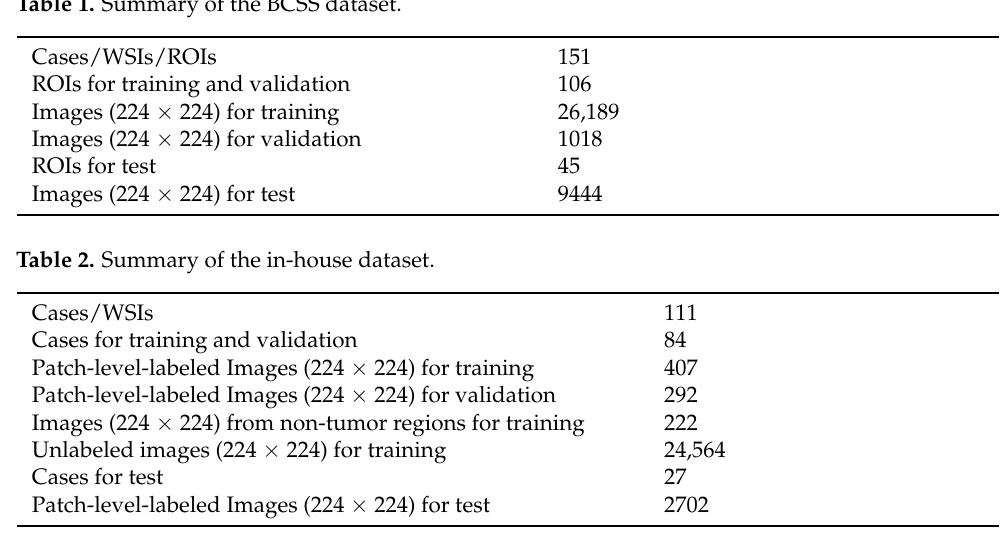
Table 1. Summary of the BCSS dataset.